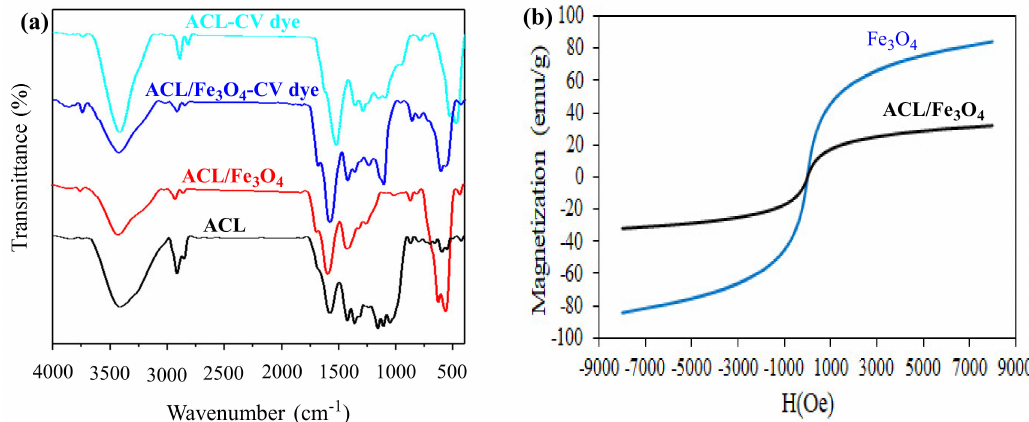
Figure 1. ( a ) Fourier-transform infrared spectroscopy (FTIR) analysis for ACL and ACL/Fe 3 O 4 magnetic nanocomposites before and after CV dye adsorption process; and ( b ) Vibrating sample magnetometer (VSM) analysis for Fe 3 O 4 and ACL/Fe 3 O 4 magnetic